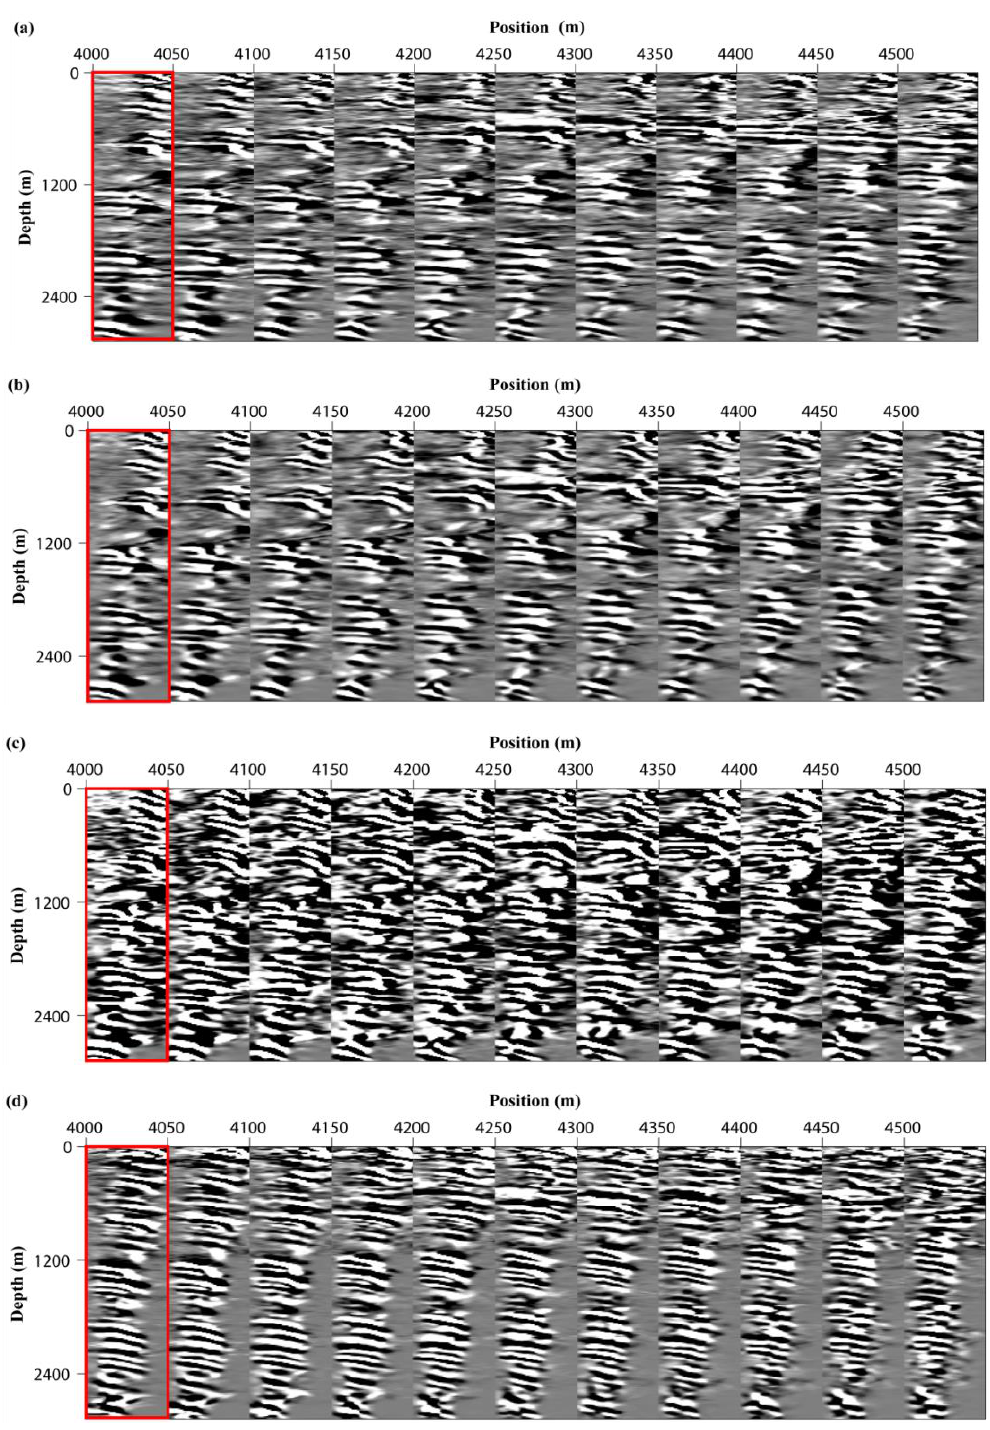
Figure 7. Comparison of angle gathers generated by using ( a ) Method 1, ( b ) Method 2, ( c ) Method 3 and ( d ) Method 4. Over 8% than true velocity model is used for migration. The reflection angle from left to right is 0 to 50°. All four images are regularized to the same amplitude scale.